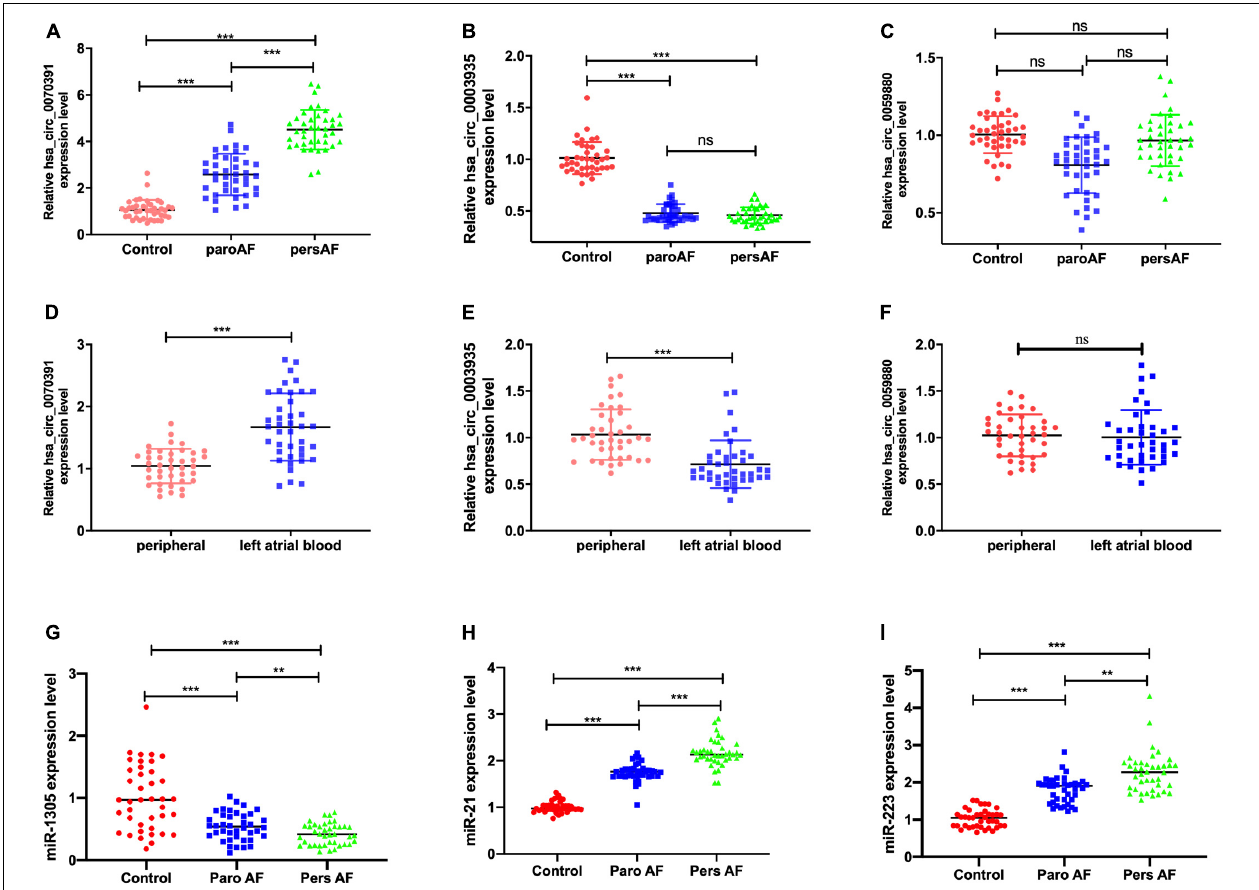
FIGURE 5 | Corroboration of the expression level of the 3 circRNAs in plasma in AF by qRT-PCR. (A) The peripheral plasma hsa_circ_0070391 expression level in different types of AF and controls. (B) The peripheral plasma hsa_circ_0003935 expression level in different types of AF and controls. (C) The peripheral plasma hsa_circ_0059880 expression level in different types of AF and control. (D) The plasma hsa_circ_0070391 level in peripheral blood and left atrial blood. (E) The plasma hsa_circ_0003935 level in peripheral blood and left atrial blood. (F) The plasma hsa_circ_0059880 level in peripheral blood and left atrial blood. (G) The peripheral plasma has-miR-1305 expression level in different types of AF and controls. (H) The peripheral plasma has-miR-21 expression level in different types of AF and controls. (I) The peripheral plasma has-miR-223 expression level in different types of AF and controls. *** p < 0.001, ** p < 0.01, ns: no significance. Paro AF, paroxysmal AF; Pers AF, persistent